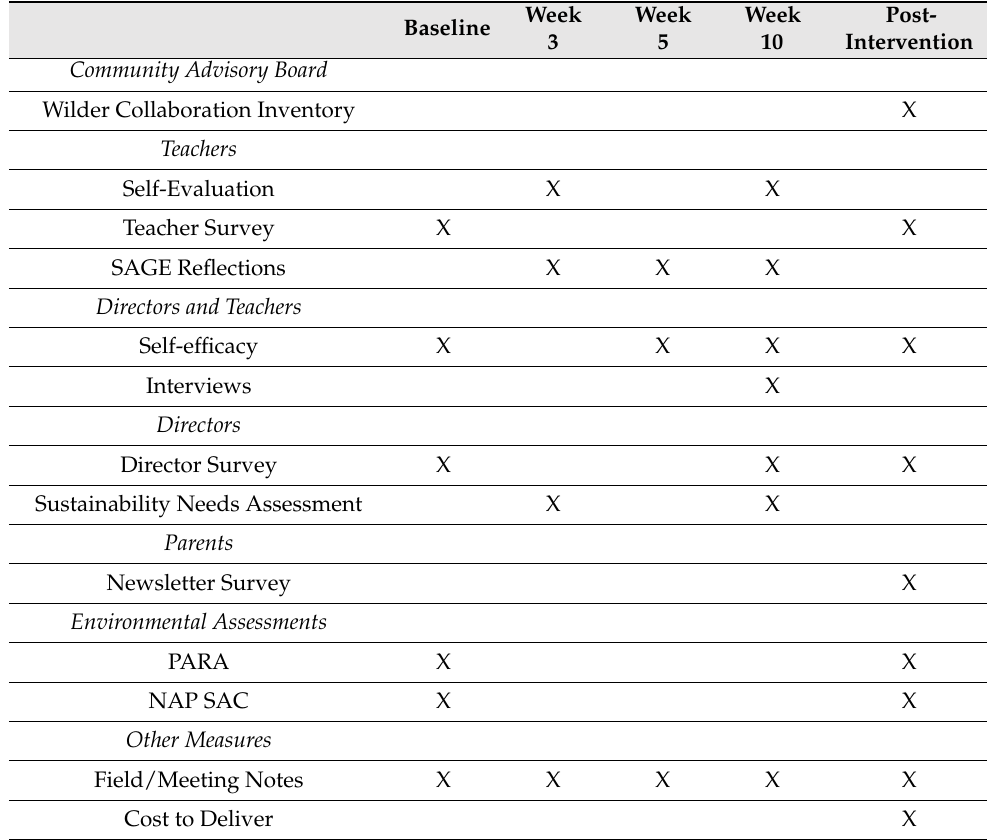
Table 2. Timing of SAP